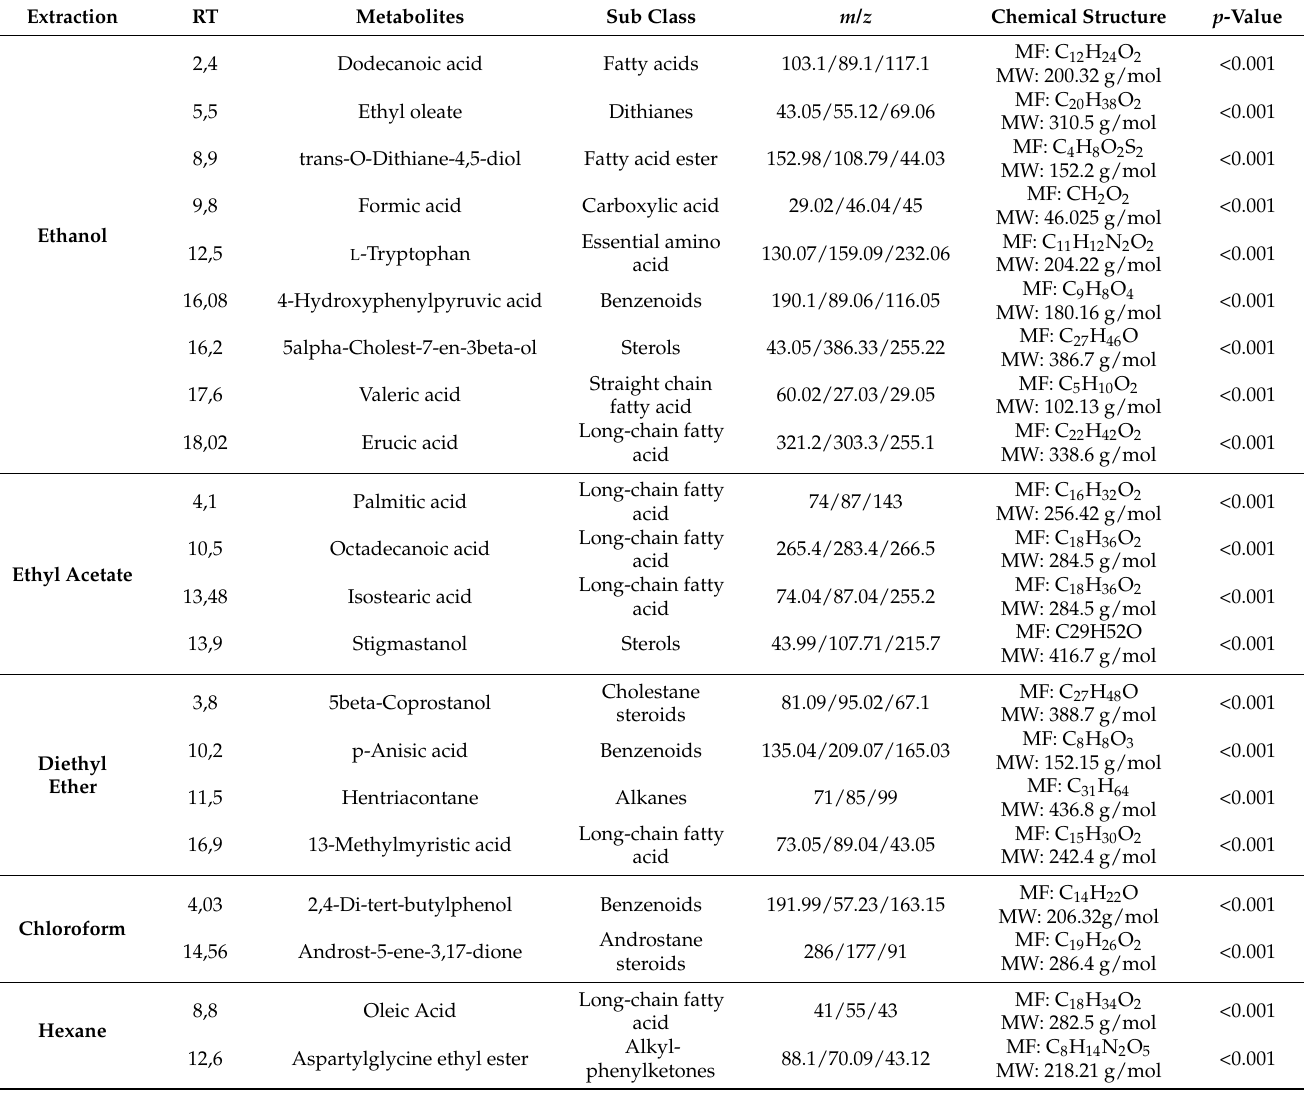
Table 2. Biomarkers selected in the fecal metabolic profiles of KT